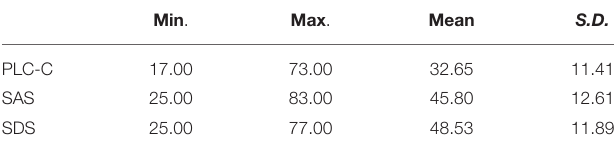
TABLE 3 | Descriptive statistics of PTSD, depression, and anxiety in survivors.